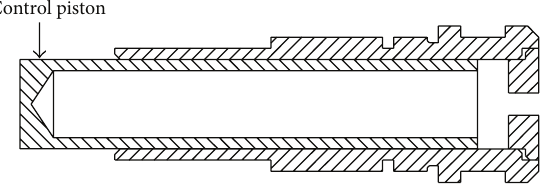
Figure 4: Sectional view of control cylinder assembly.